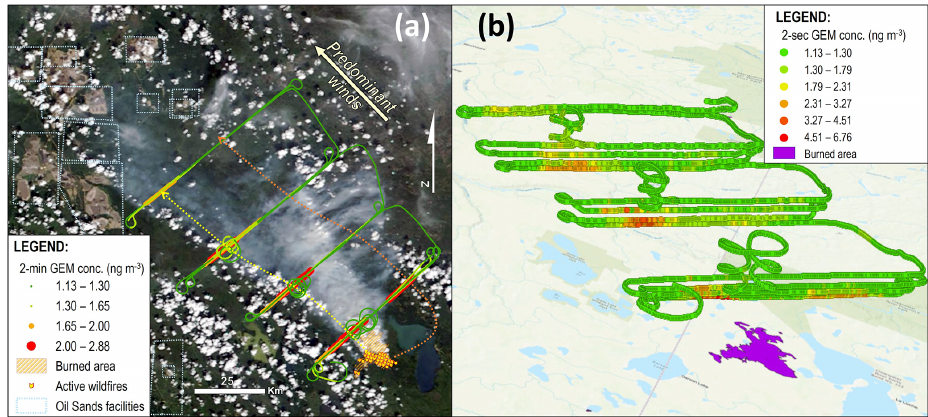
Figure 2. Panel (a) shows the 2min measured GEM concentrations along the flight track, overlaid onto the satellite image of the wildfire taken from MODIS satellites at approximately 18:59GMT on 25 June 2018 (near end of flight) (NASA, 2020). Yellow and orange dotted lines in panel (a) show approximate path of the south and north plumes, respectively. Panel (b) shows the 2s GEM concentration calculated by conversion of the 0.5Hz CO data using the GEM : CO emissions ratio (ER) along the flight path in three dimensions (ArcGIS,